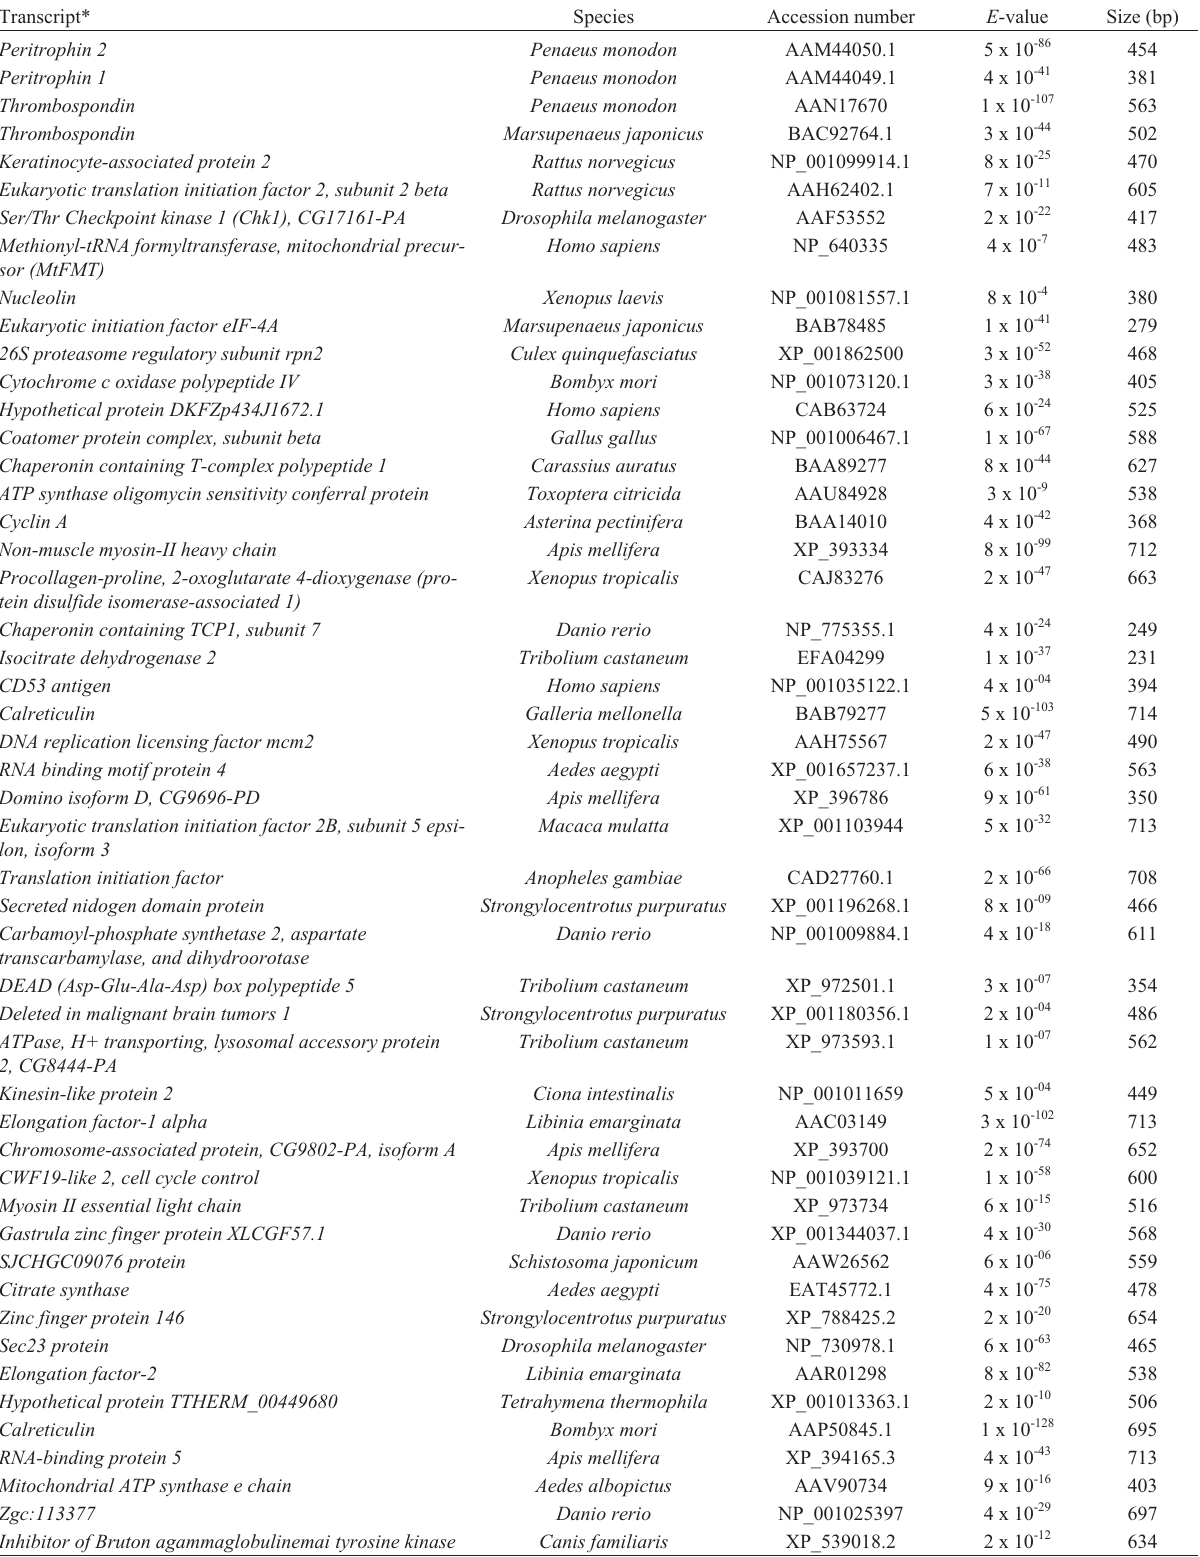
Table 2 - Examples of known transcripts excluding ribosomal proteins found in the forward ovarian SSH library (cDNAs from stage III ovaries as the tester and those from stage I ovaries as the driver) of P. monodon